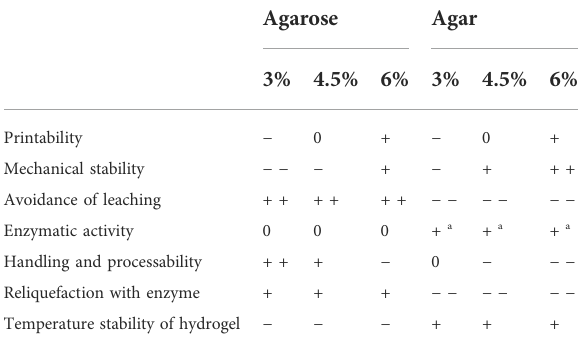
TABLE 2 Qualitative ratings of low-melt agarose and agar bioinks regarding a range of criteria determining their suitability for the printing of biocatalytically active